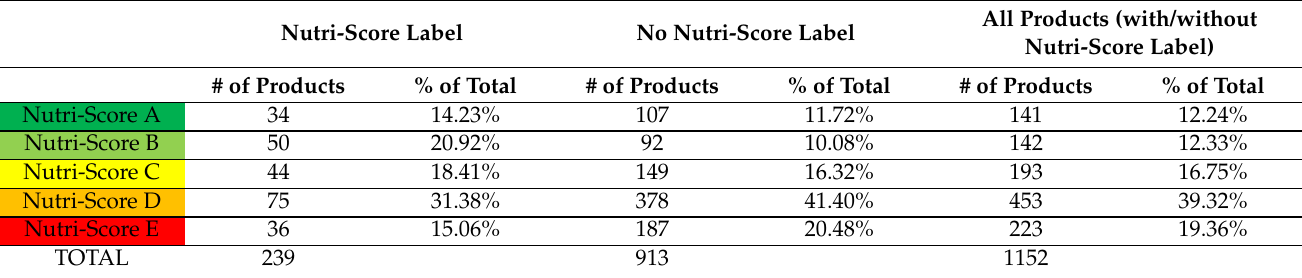
Table 1. Link between Nutri-Score group and voluntary display ( n =